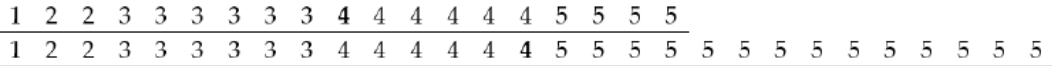
Figure 2. Example of the median position [16].